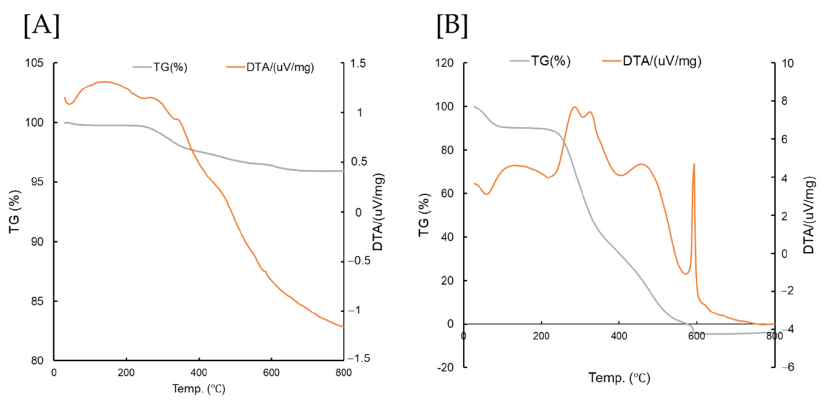
Figure 4. TG/DTA of α -TCP/GS ( A ) and GS ( B ); TG/DTA, thermogravimetric and differential thermal analyses; α -TCP/GS, composite gelatin sponge; and GS, gelatin scaffolds. The gray line represents the results of TGA and the orange line represents the results of DTA.